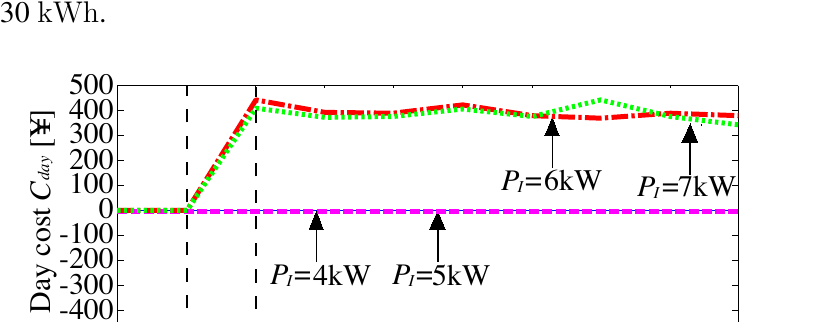
Figure 2. Optimal dimension of storage battery. ( a ) 10 kWh –100 kWh ; ( b ) 20 kWh –30 kWh